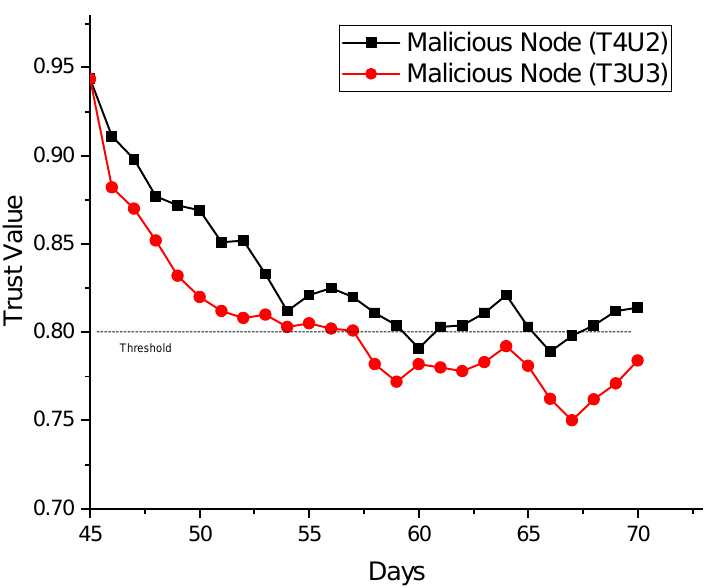
Figure 4. Trust values of malicious node (e.g., node D) calculated by target node (e.g., node A) under Scenario 1.